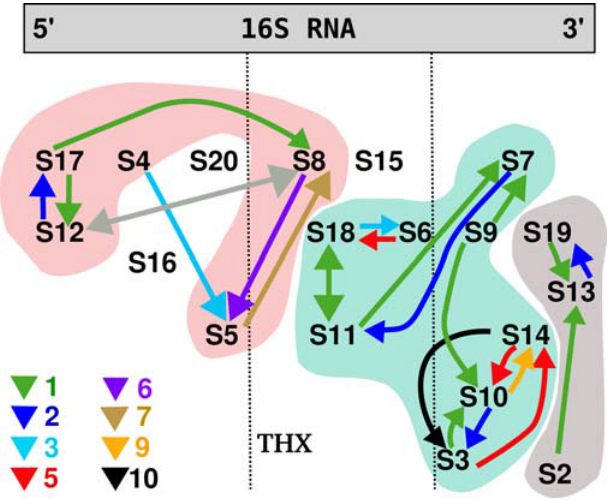
Figure 2. The Influence Network of the Presence of Single Proteins on the Binding Stability of the Other Proteins The three clusters and the four unaffected proteins are visible. The colors of the arrows indicate D r (the larger the number, the stronger the influence). The arrows point from the removed protein to the affected protein, e.g., removal of S4 alters the binding strength of S5 with the ‘‘ influence strength ’’ of 3. The gray arrows indicate the interaction that is due to very small relative energy change and involves the ‘‘ suspicious ’’ protein S12 (see text for details). DOI: